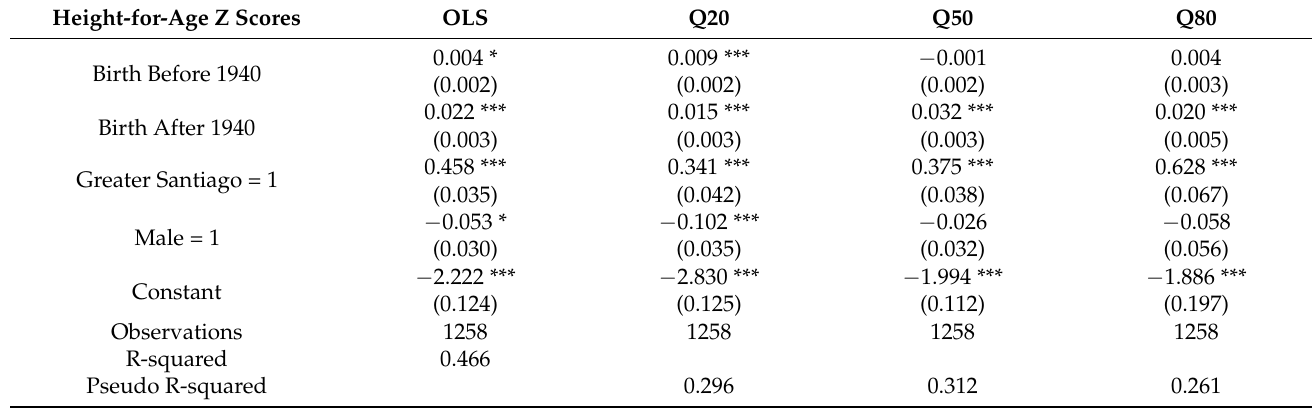
Table A3. OLS and quantiles regressions with breaks in 1940.